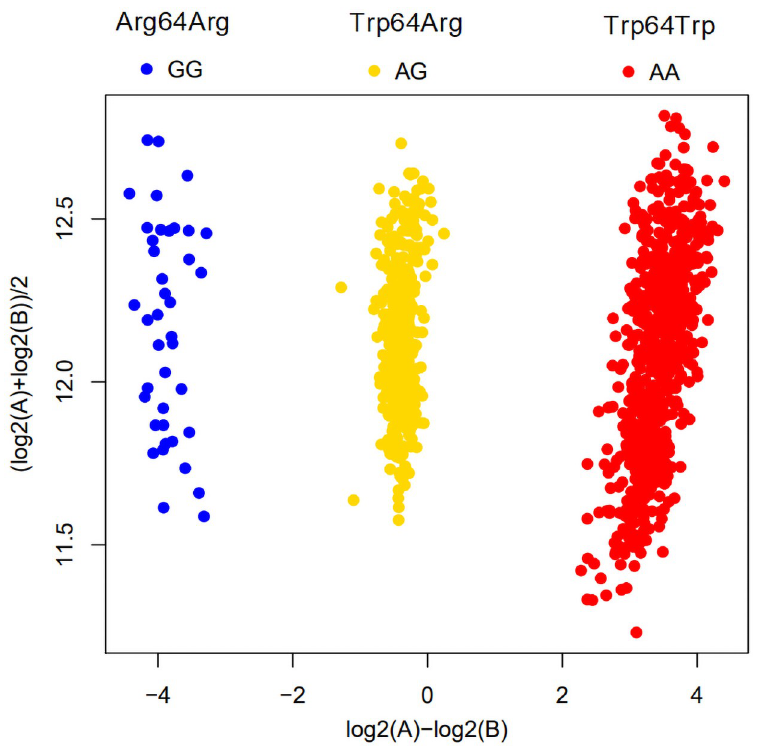
Fig 2. The genotyping result of rs4994 using the Japonica Array v2. X- and Y-axes indicate logarithmic ratio and logarithmic mean of A and B signals,